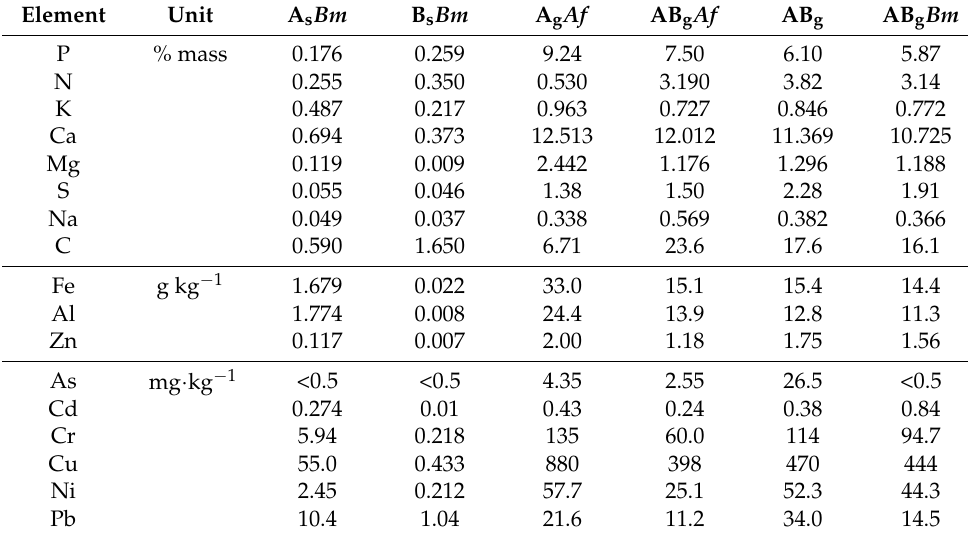
Table 2. Elemental composition of recycled P-fertilizers 1 . Element Unit